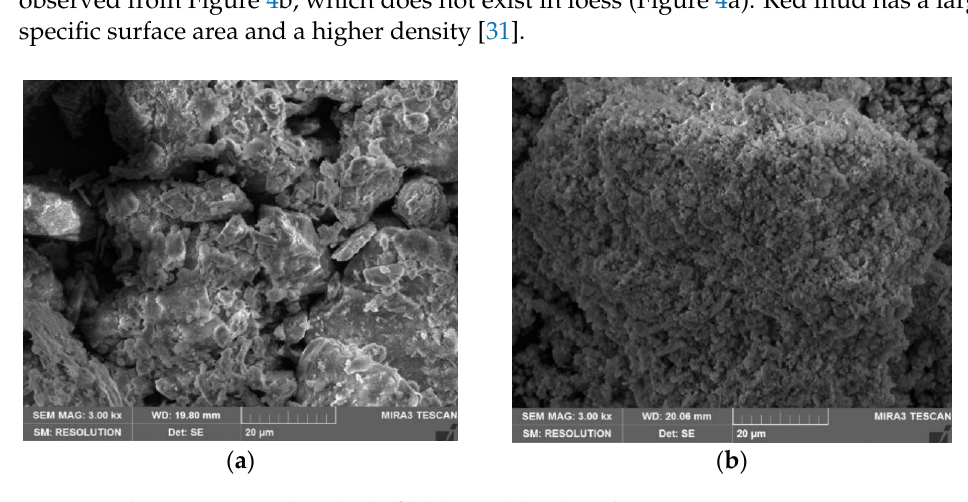
Figure 4. The SEM images (3.00 k×) of ( a ) loess, ( b ) red mud.